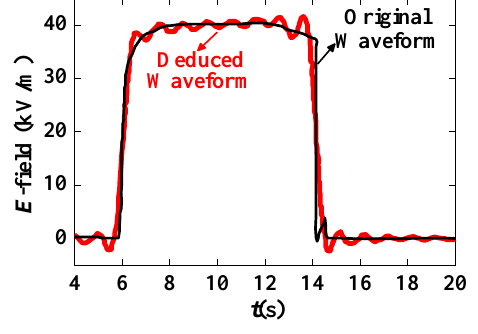
Figure 21. The deduced excitation waveform and the original